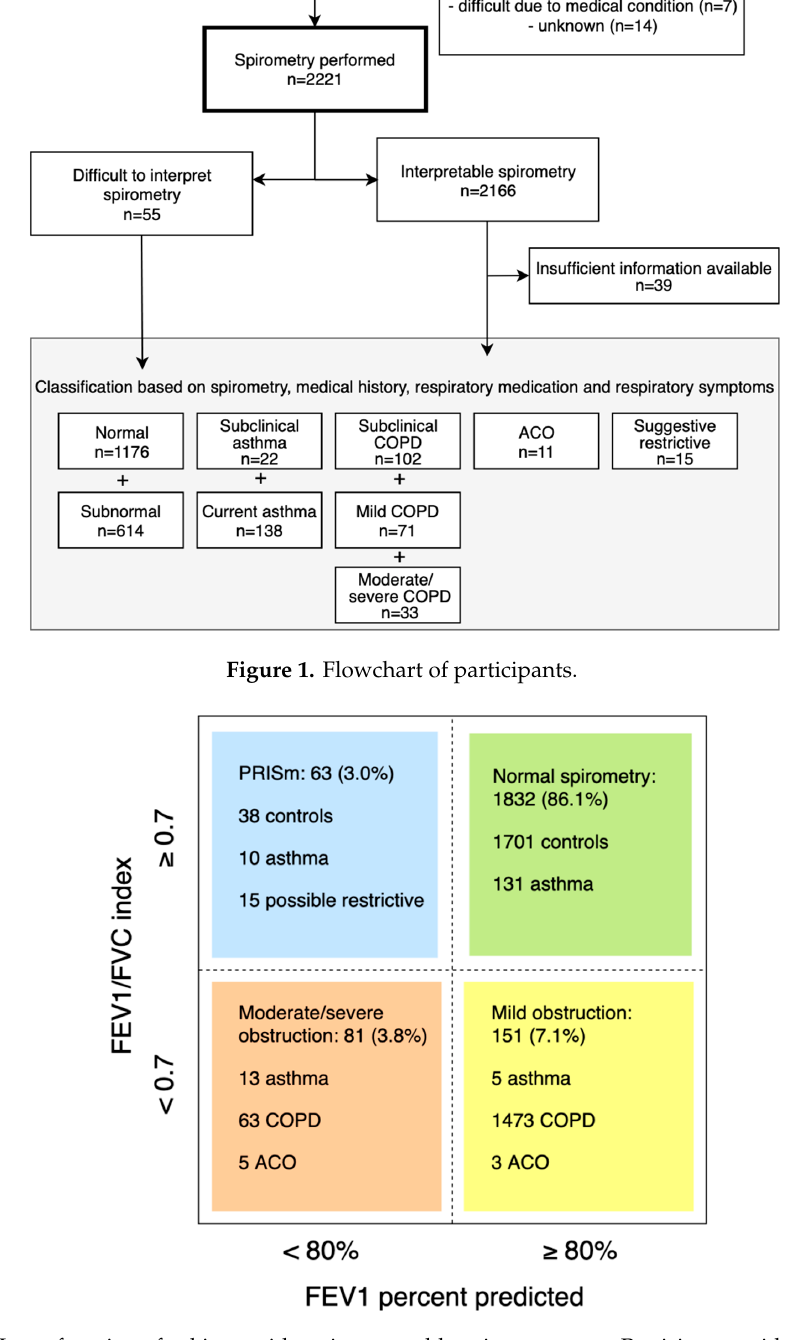
Figure 2. Lung function of subjects with an interpretable spirometry test. Participants with insufficient clinical information, available to categorize in a lung function group, were excluded ( n = 39).